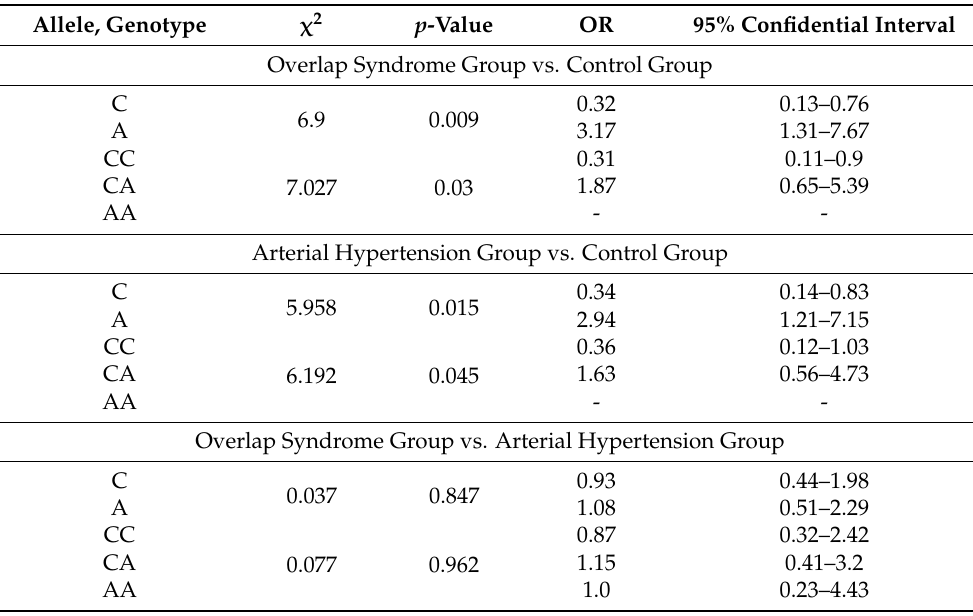
Table 3. Odds ratio (OR) of tension-type headache and arterial hypertension overlap syndrome depending on alleles and genotypes of rs2779249 of the NOS2 gene. Allele, Genotype χ 2